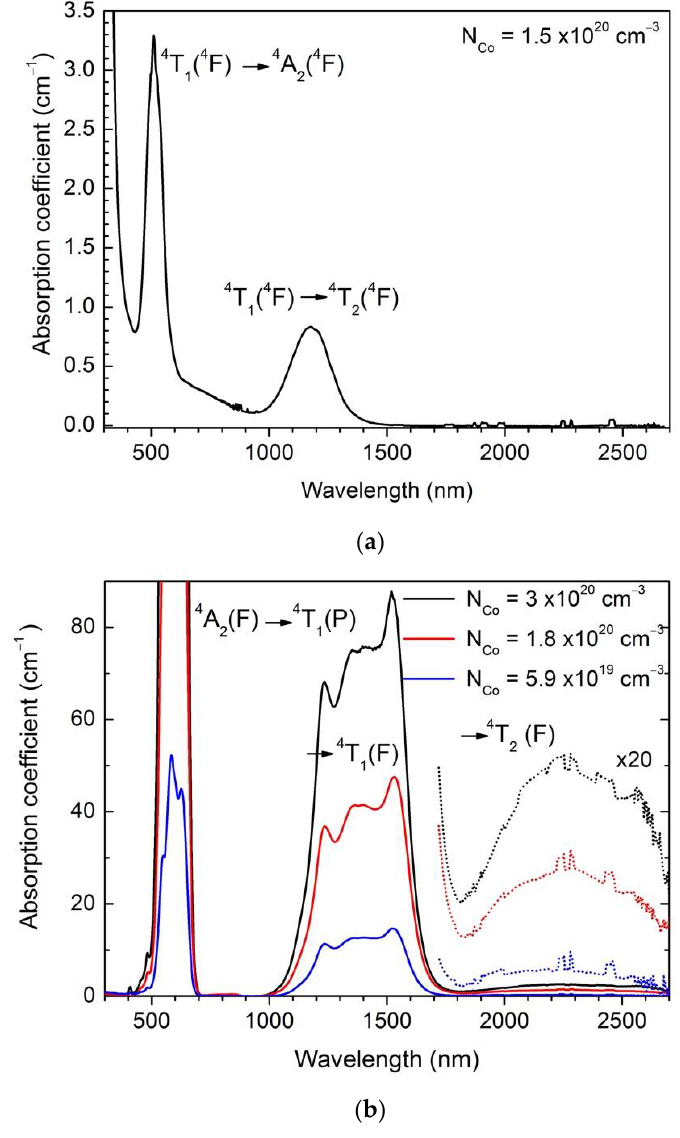
Figure 6. Optical absorption spectra of ( a ) MgO:Co and ( b ) MgAl 2 O 4 :Co single crystals. Cobalt ion concentration, measured by EDS, is given in the legend. The dotted lines in the MgAl 2 O 4 spectra are magnified ×20 to better appreciate the long wavelength absorption band.